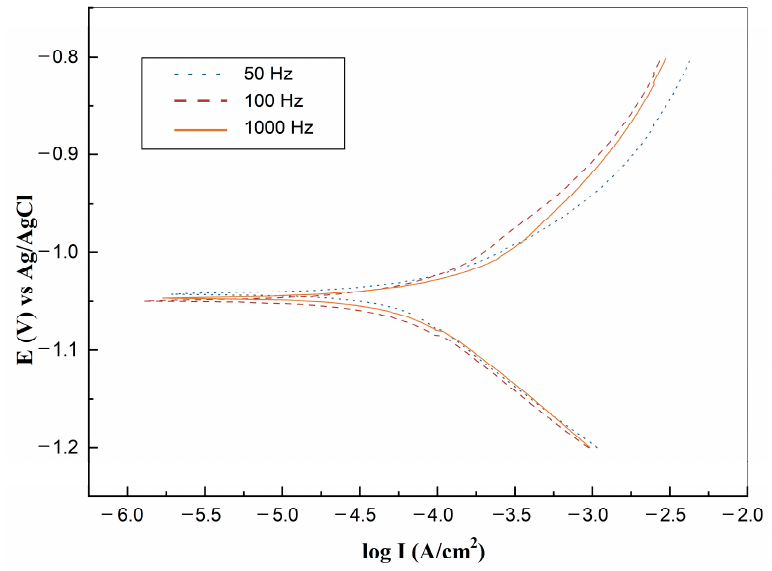
Figure 8. Tafel plot of zinc under 50 Hz, 100 Hz, and 1000 Hz, respectively (37 °C immersed in Hank’s solution for 30 min). Table 2. Electrochemical parameters of zinc under 50 Hz, 100 Hz, and 1000 Hz, respectively.